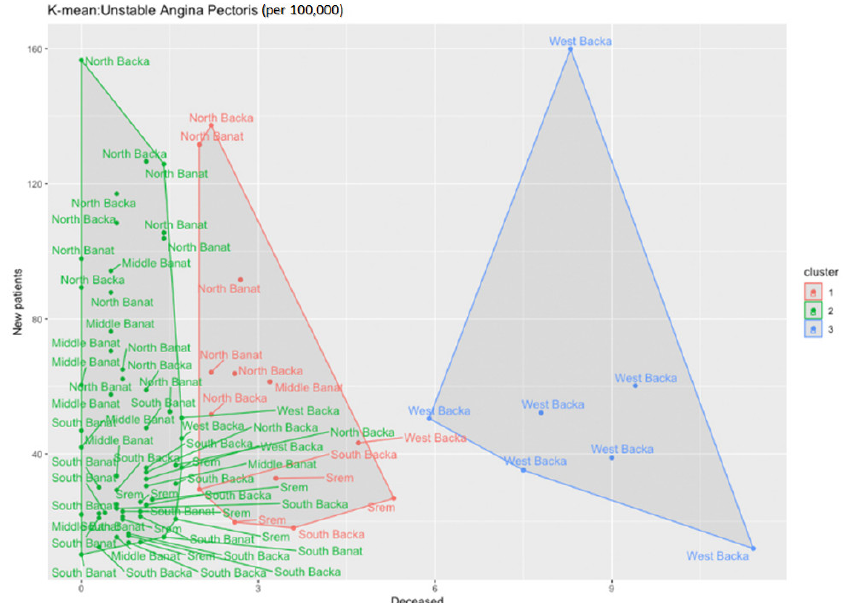
Figure 12. Identification of clusters during the analysis of patients deceased from unstable angina pectoris in the researched area.